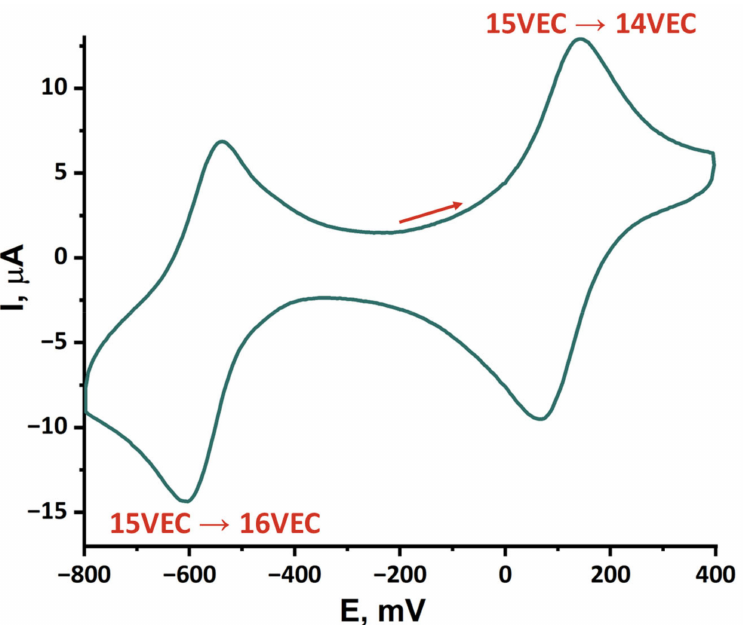
Figure 9. Cyclic voltammetry of the Mo 5 red (0.5 mM) in 0.1 M Bu 4 NClO 4 acetonitrile solution, scan rate of 500 m vs. reference electrode, Ag/AgCl/3.5 M